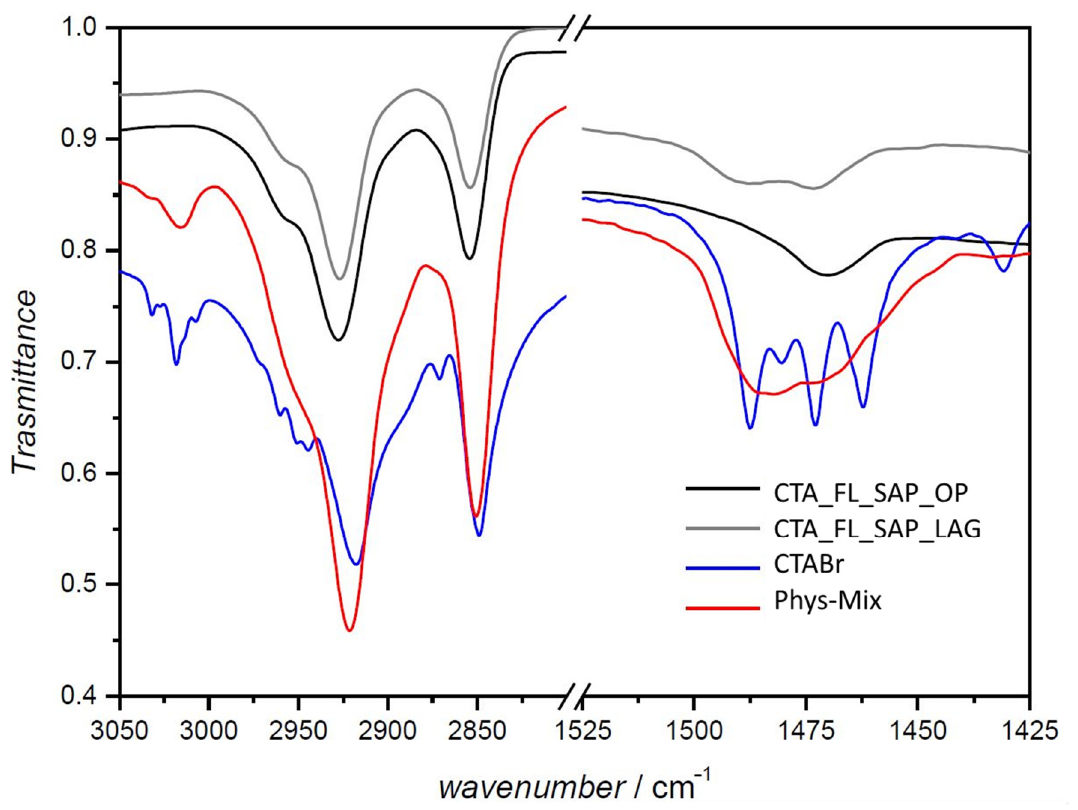
Figure 3. FTIR spectra of CTA_FL_SAP_OP (black), CTA_FL_SAP_LAG (grey), CTABr (blue), Phys- Mix (red). (Left) region of CH 2 stretching modes; (right) region of CH 2 bending modes.